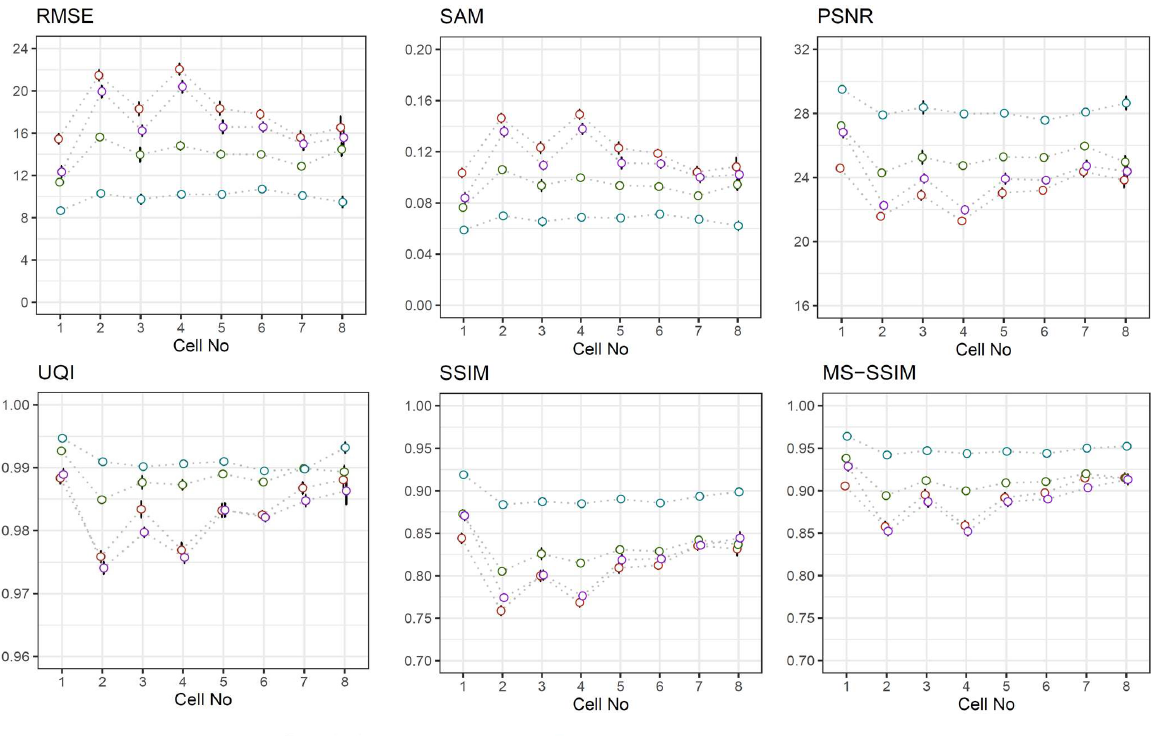
Figure 8. Similarity metrics against cell number for different image